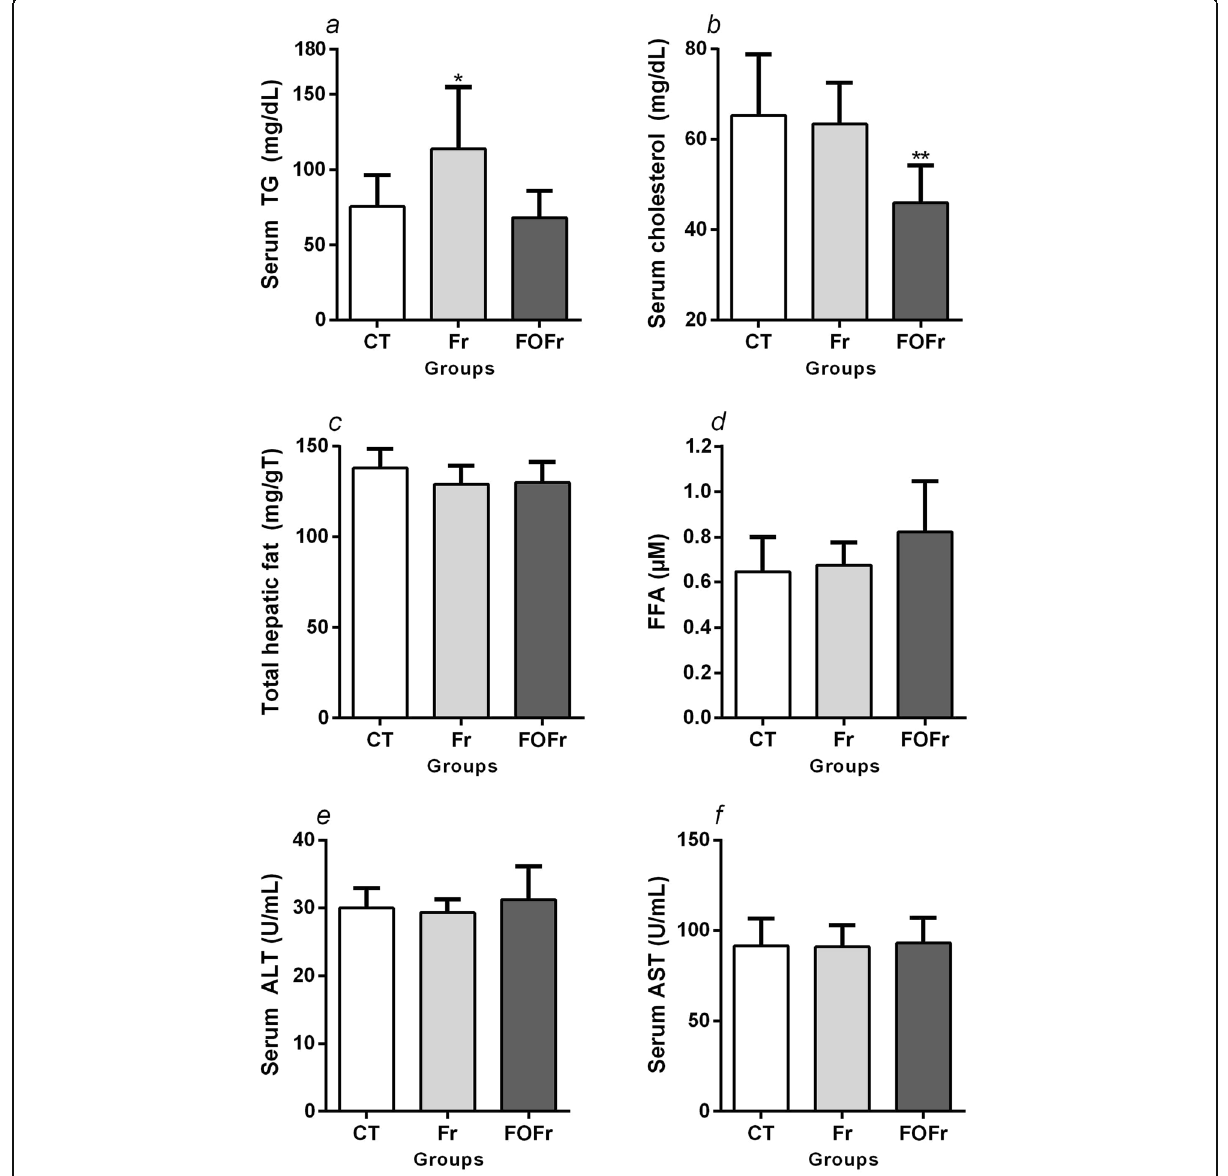
Fig. 3 Biochemical parameters. a Serum triglycerides, b serum total cholesterol, c total hepatic fat, d free fatty acids, and e serum ALT and f AST. Values are mean ± SD. Asterisk indicates a significant difference when compared to CT and FOFr. Double asterisk indicates a significant difference when compared to CT and Fr ( P <